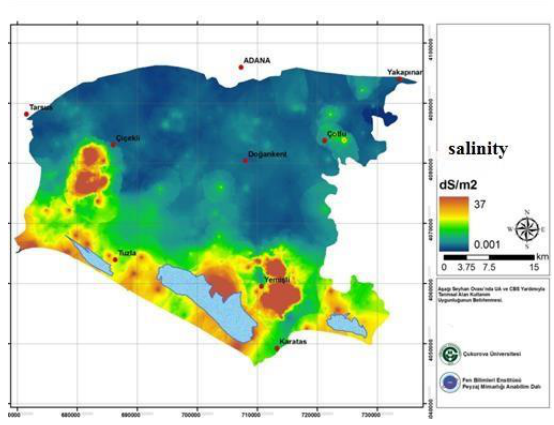
Figure 6. Soil salinity map produced by DSI.